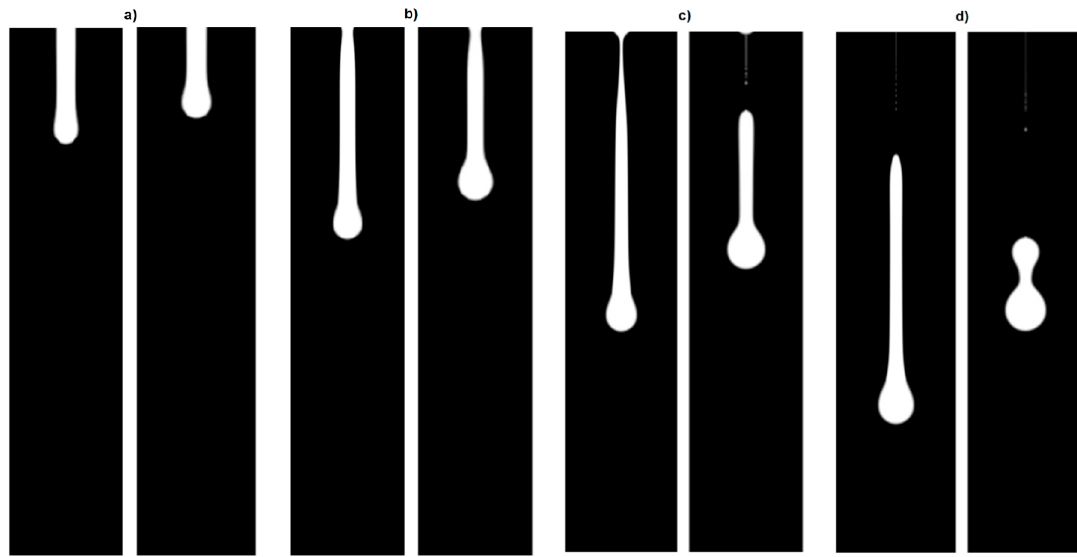
Figure 3. Comparison between surface tensions at the following four time steps: ( a ) 6 µ s, ( b ) 12 µ s, ( c ) 18 µ s, and ( d ) 24 µ s.